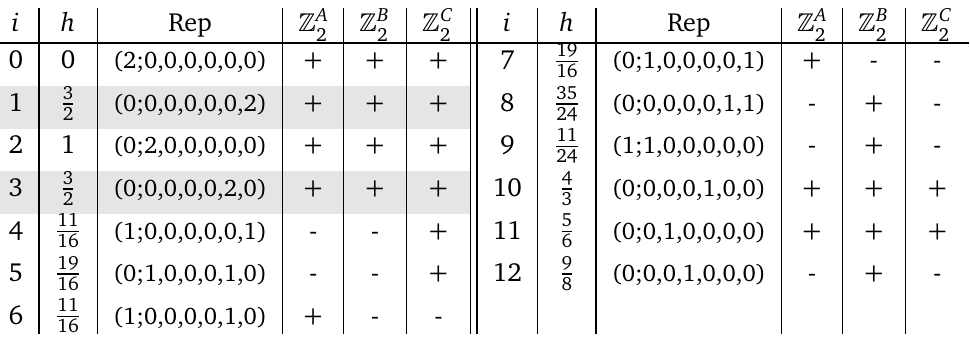
( τ ) . Primaries i = 1,2,3 are the generator of (cid:90) A i subgroup of the center symmetry (cid:90) 2